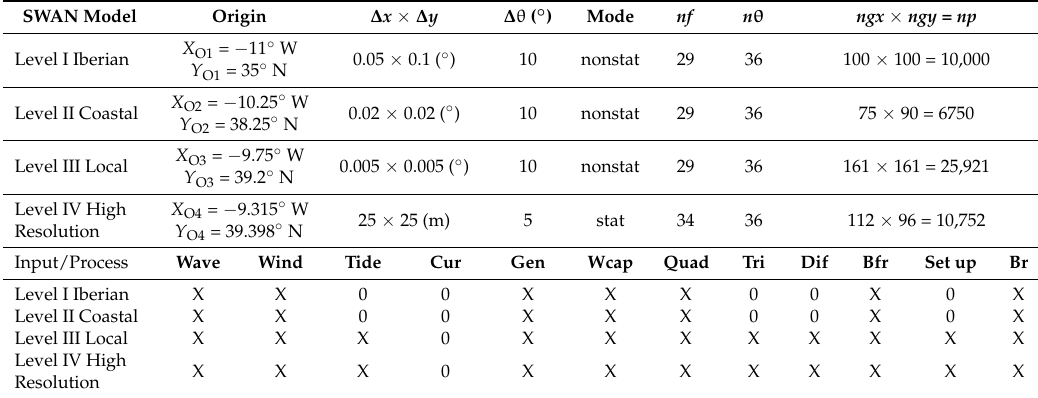
Table 2. Characteristics of the computational domains defined for the SWAN simulations and description of the physical processes activated at each